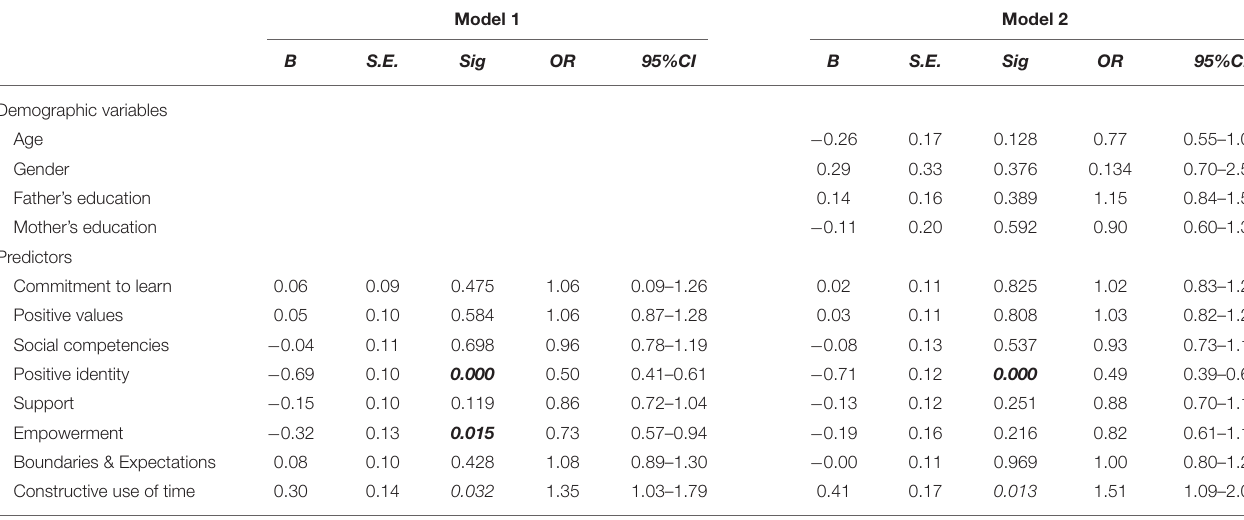
TABLE 4A | Associations between the eight developmental asset categories and prolonged sadness: logistic regression